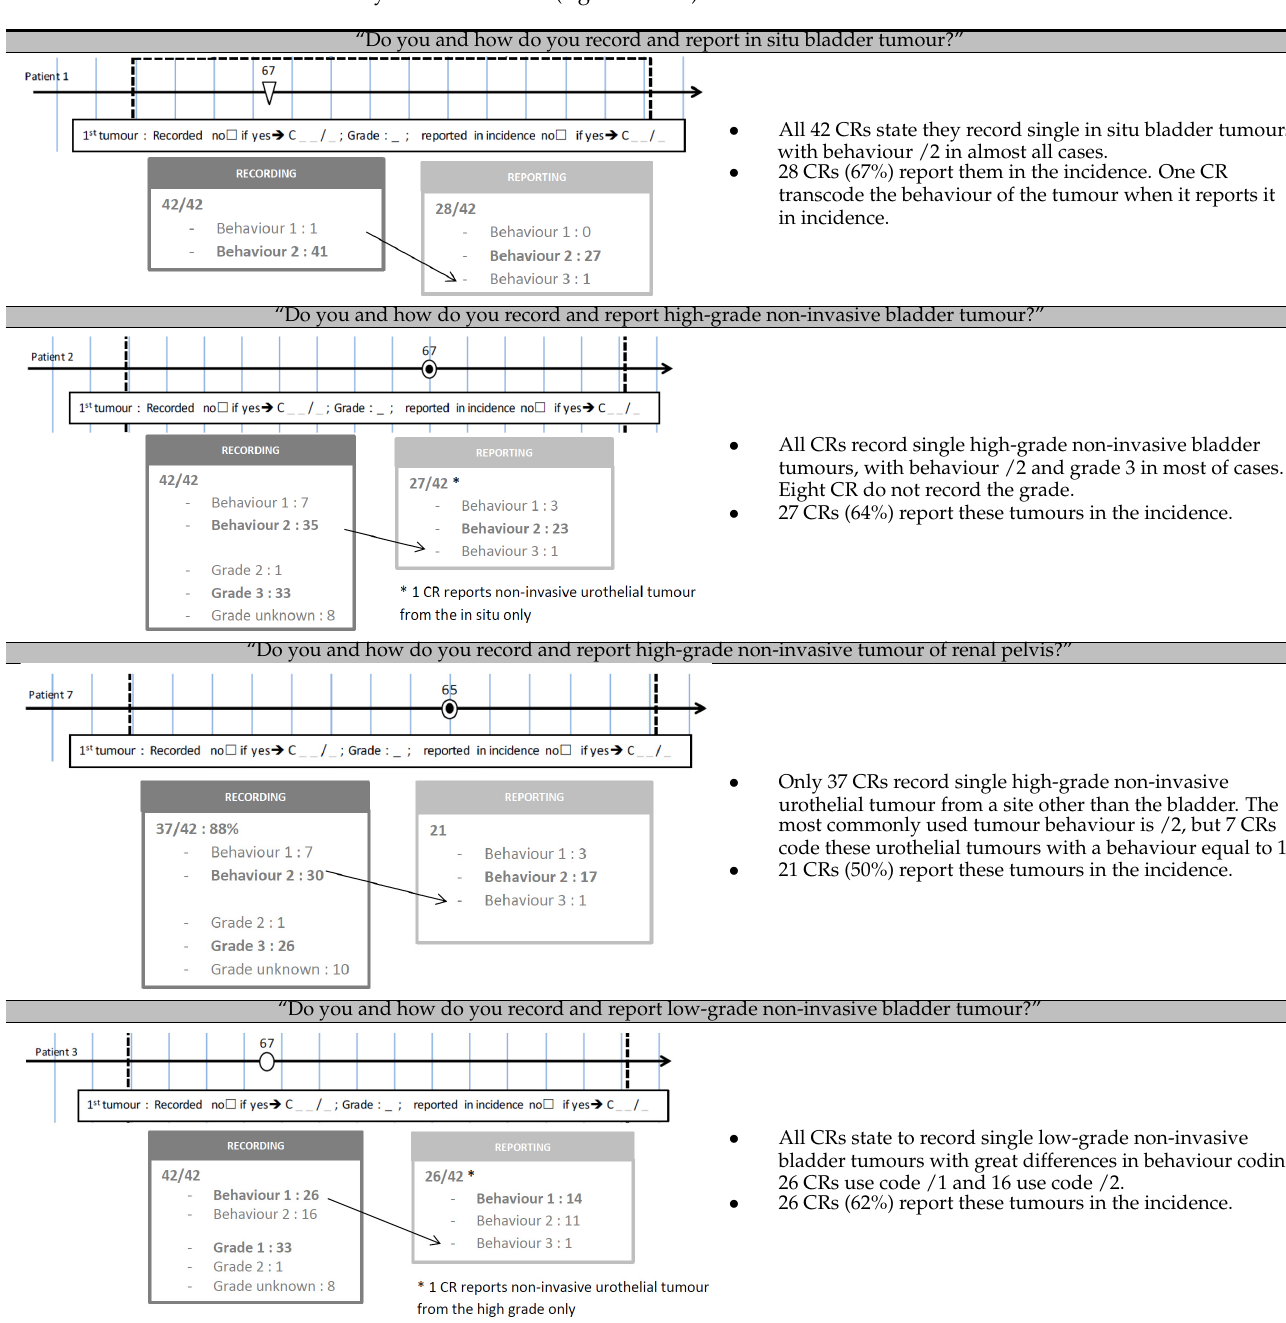
Table A1. Clinical situations presented to the cancer registries and answers (left columns) and analyses of the results (right column).